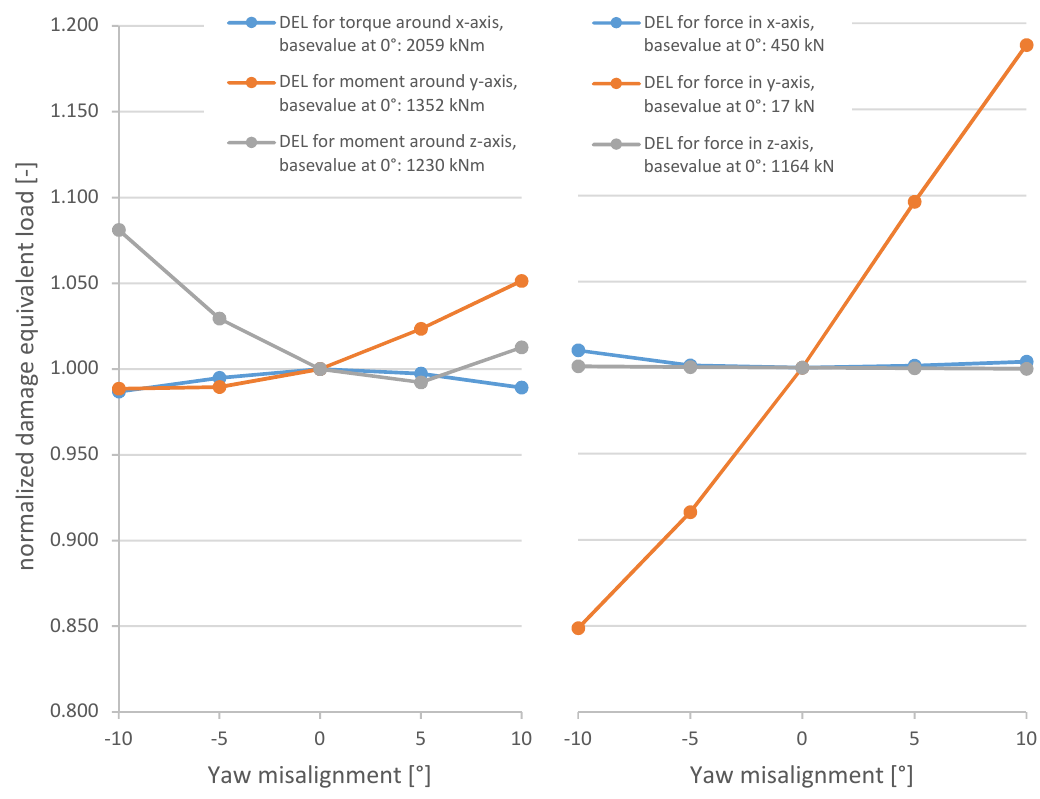
Figure 6. Damage equivalent load for the loads in all six degrees of freedom, various nacelle positions and a timespan of 20 years for an exponent of k = 3.3 ( left : moments; right : forces).